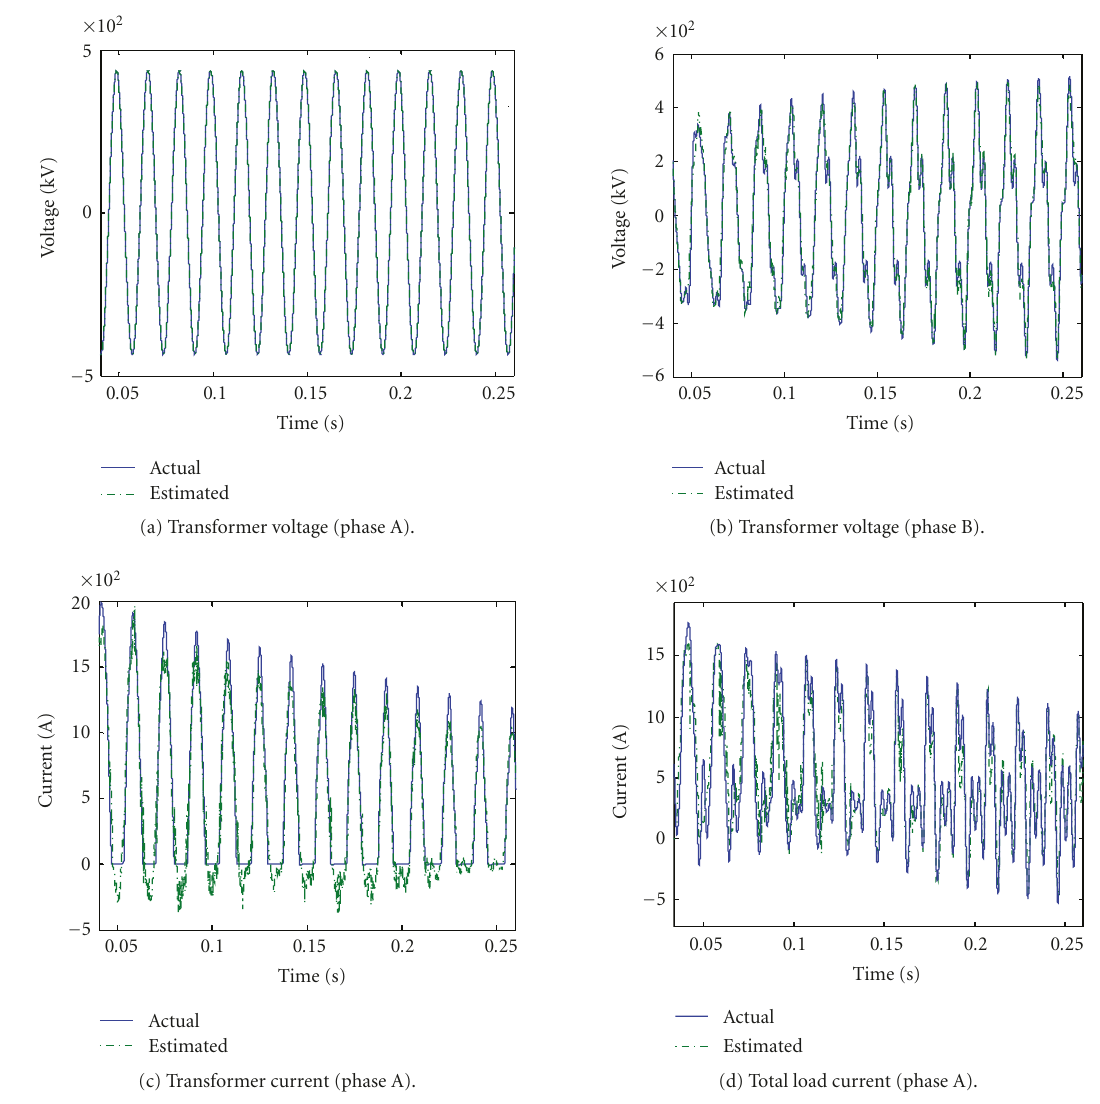
Figure 4: Actual and estimated voltages and